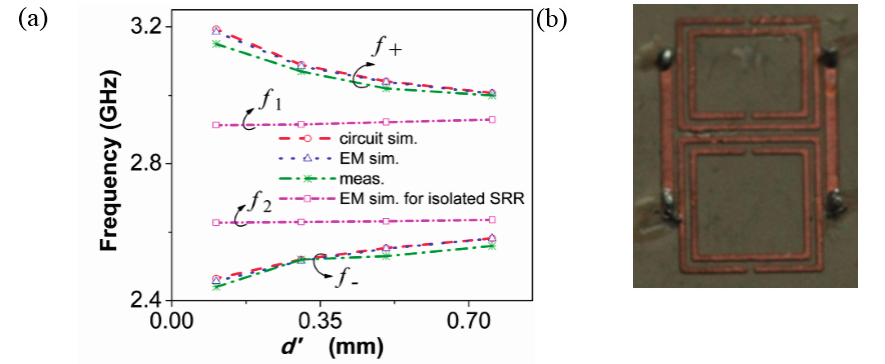
Figure 15. Frequency response (symmetric case) for different values of d’ ( a ), and detail of one of the fabricated samples (bottom) where the ground planes have been connected through vias and strips to avoid the slot mode ( b ). From [26]; reprinted with permission from IEEE 2015.